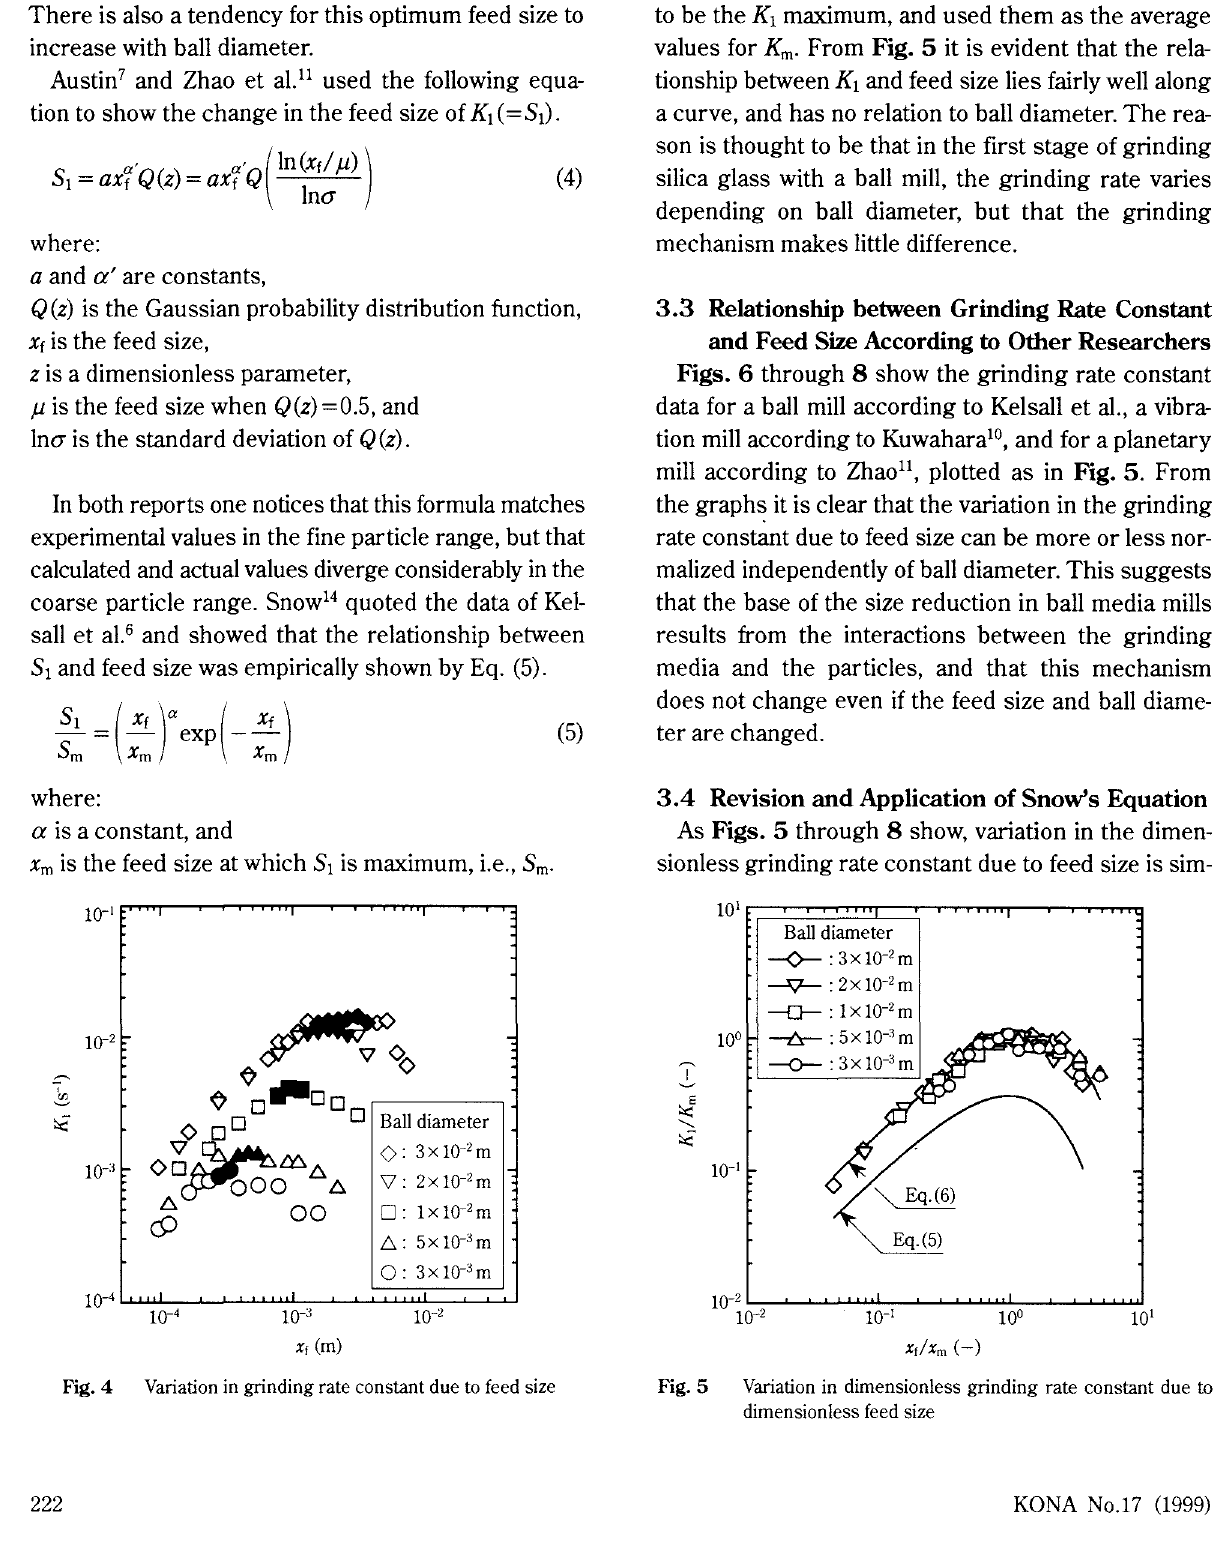
Fig. 4 Variation in grinding rate constant due to feed size Fig. 5 Variation in dimensionless grinding rate constant due to